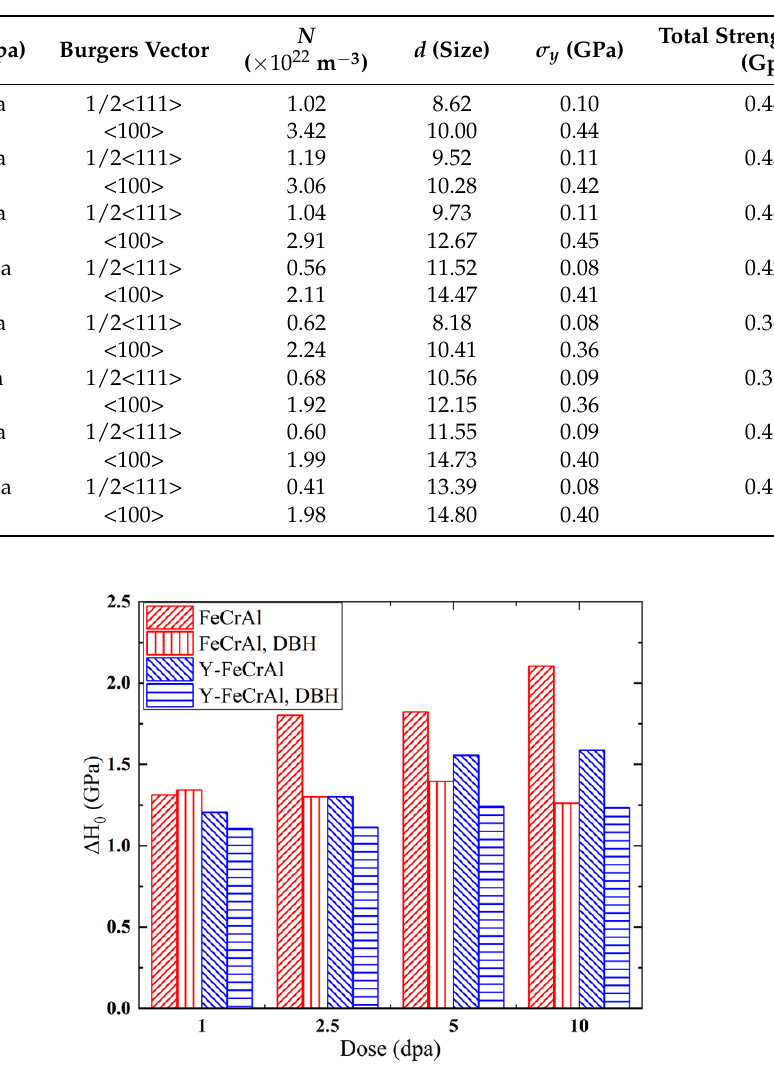
Figure 11. The hardness increment ∆ H 0 from DBH model calculation and nano-indentation test as a function of dose.